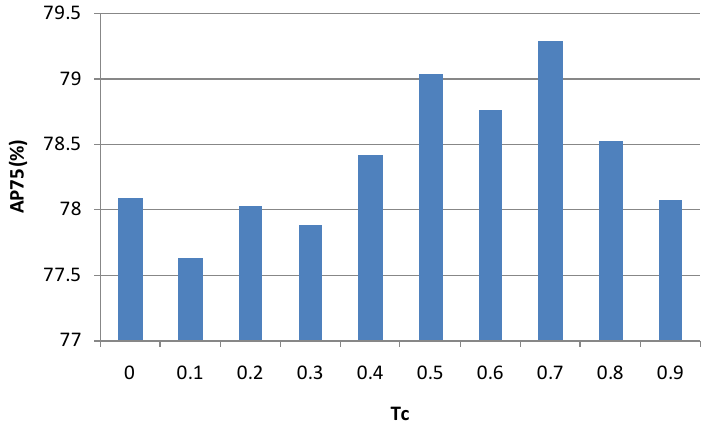
Figure 13. AP50 of models under different T c .